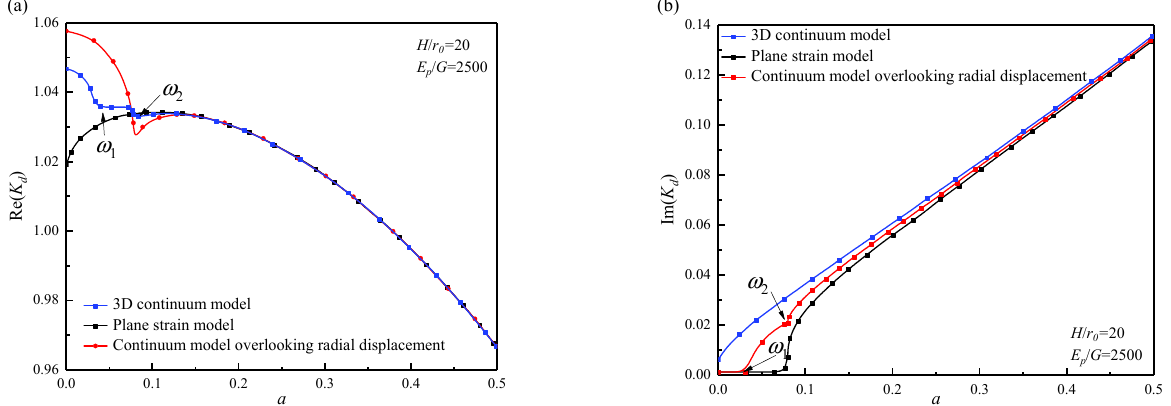
Figure 2. Pile impedance calculated by plane strain, simplified continuum model, and 3D continuum model: ( a ) dynamic stiffness; ( b ) dynamic damping (reproduced from Zheng et al. (2015) [30]).